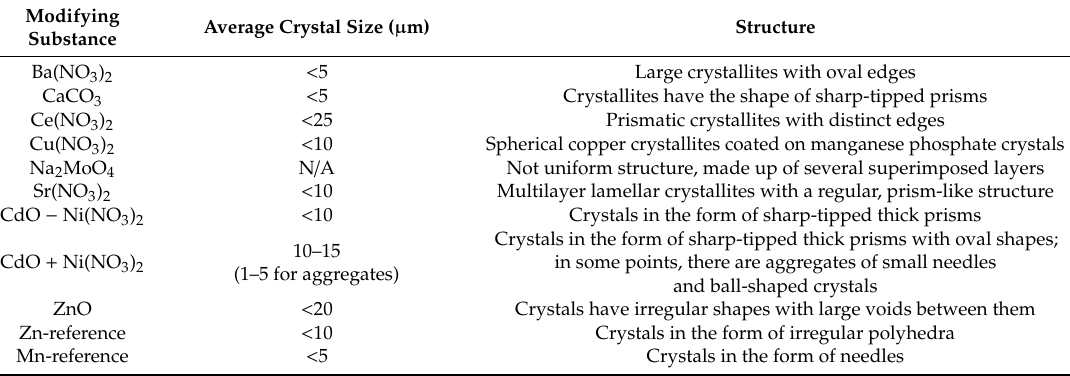
Table 5. The crystallinity of the obtained